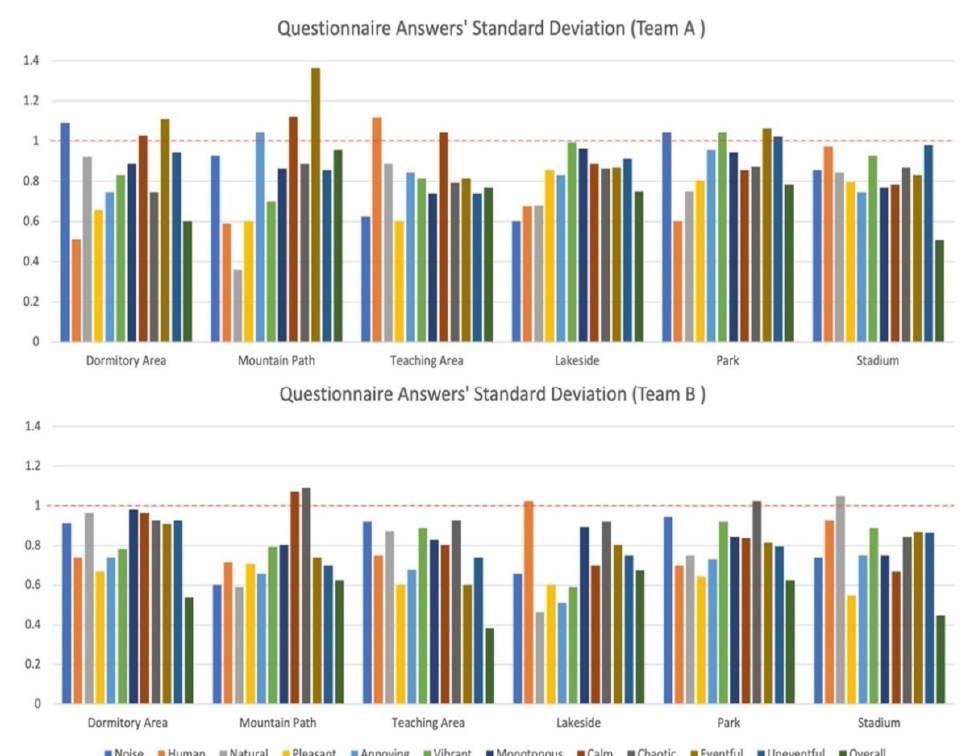
Figure 3. Standard deviations of the two teams’ questionnaire answers.